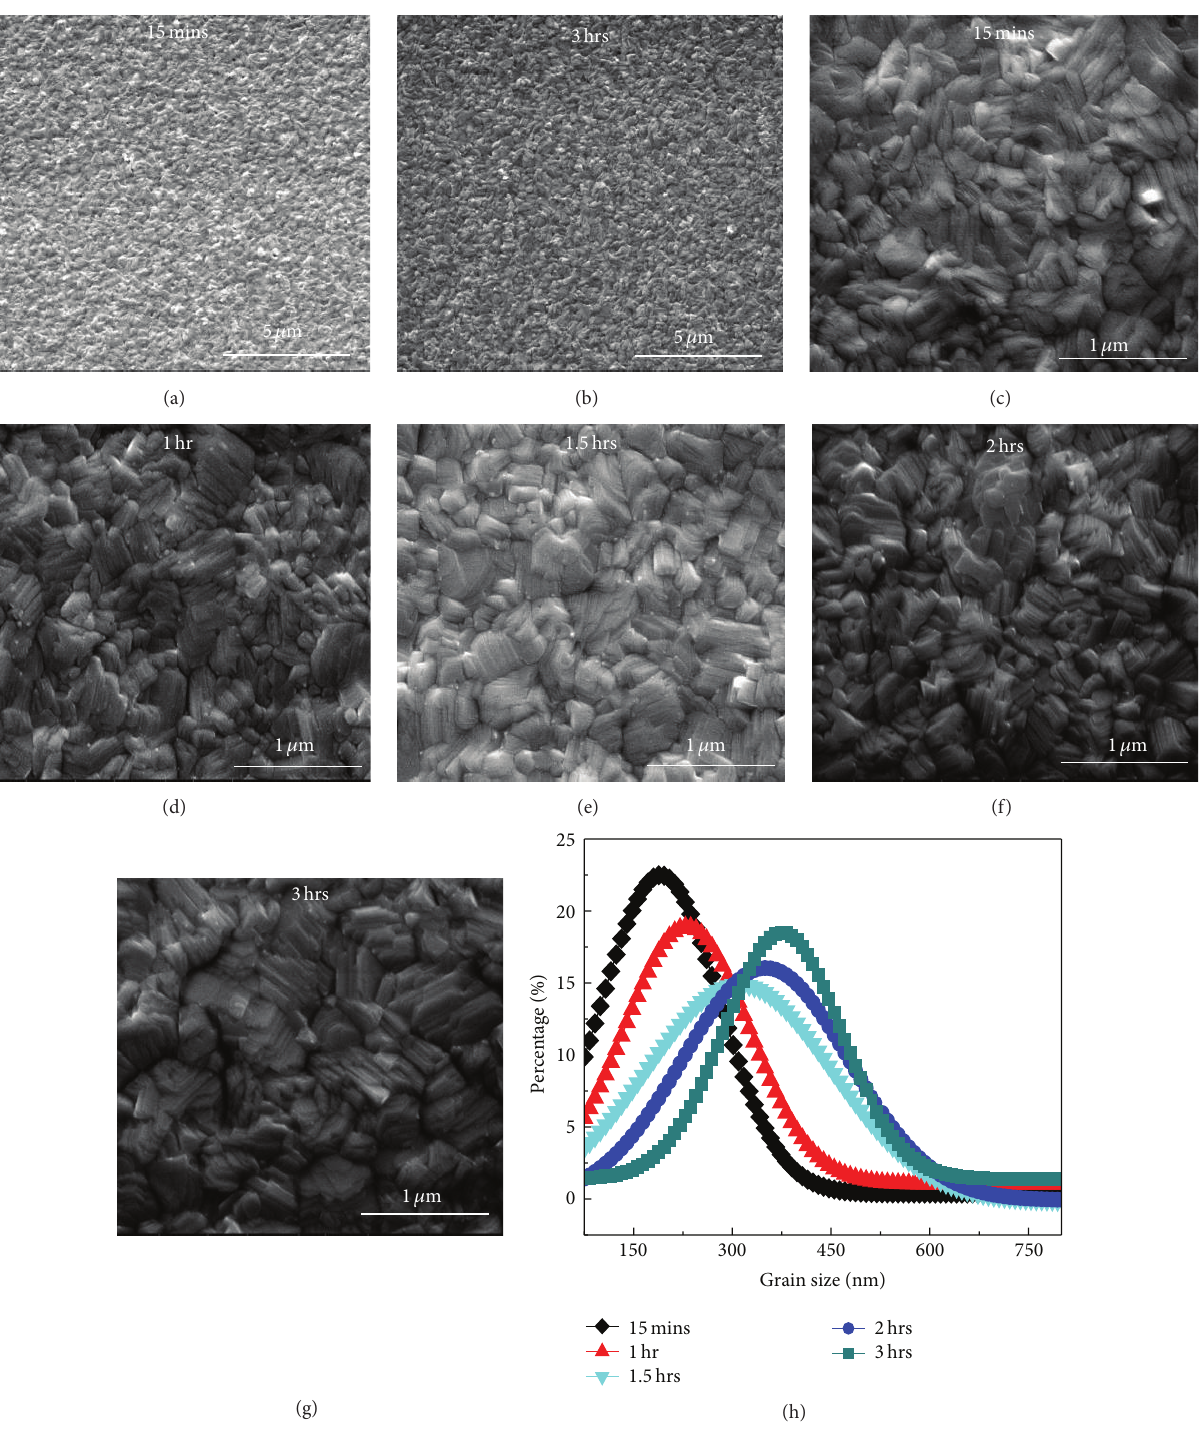
Figure 4: Grain sizes of perovskite crystal increase as a function of annealing time as shown in (a–g) top-down SEM images and (h) grain size distribution plot of films. Reproduced from [21] with permission from the Royal Society of